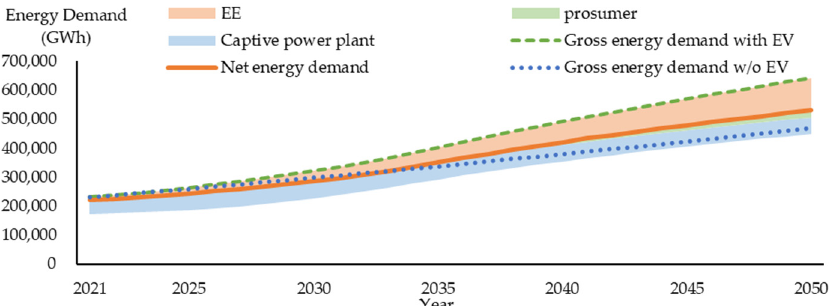
Figure 2. Gross demand forecast and net energy demand forecast.